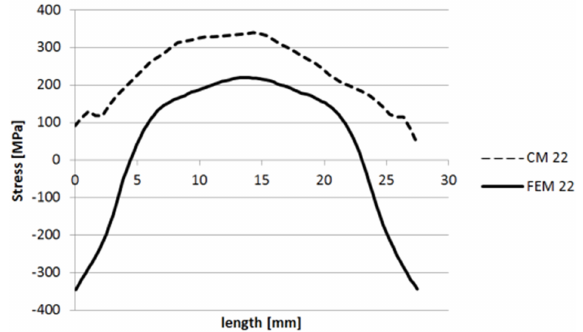
Figure 28. Stress levels in 22 direction along the CD line